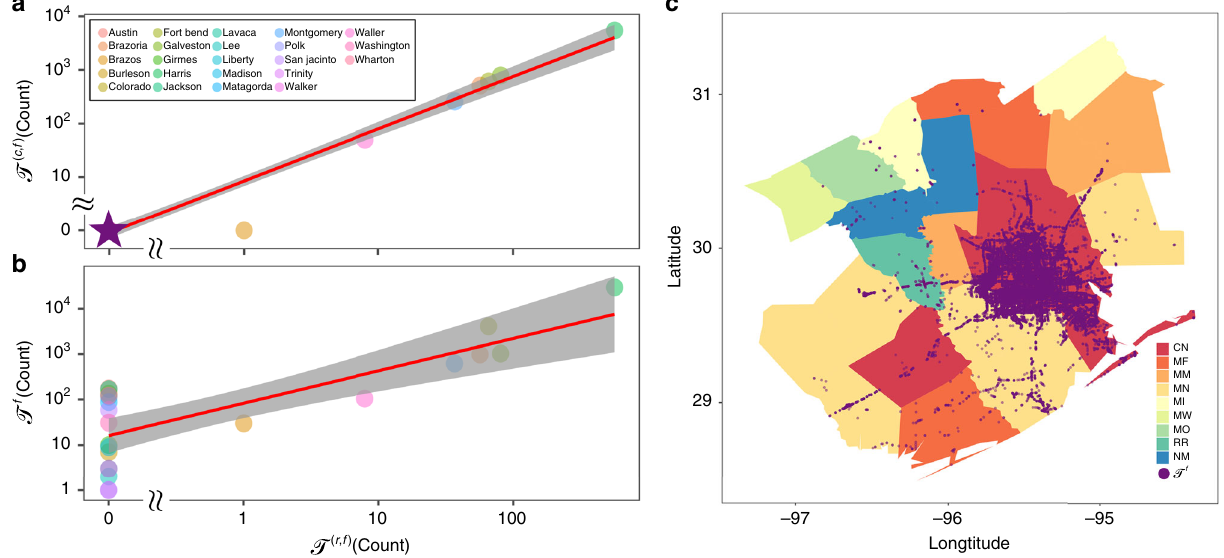
Fig. 2 Comparison of realistic data and model results. a Size of T ð c ; f Þ (the reported failures covered by total failures obtained using our failure model) as a function of the size of T ð r ; f Þ (the reported failures) in different counties. b Size of T ð f Þ (total failures obtained using our failure model) as a function of the size of T ð r ; f Þ in different counties. The purple star in a represents the sizes of T ð r ; f Þ and T ð c ; f Þ in 16 counties: Austin, Burleson, Colorado, Grimes, Jackson, Lavaca, Lee, Liberty, Madison, Matagorda, Polk, San Jacinto, Trinity, Walker, Washington, and Wharton. c Mapping of the description of fl ooding damage with total failures. Purple points in c represent T ð f